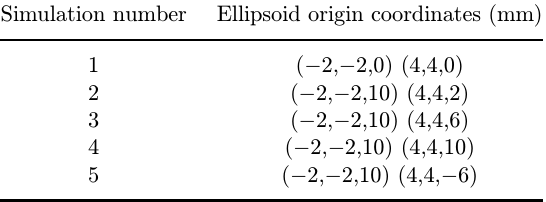
Table 2. Experiment parameter of the changed °uo- rescent volume.